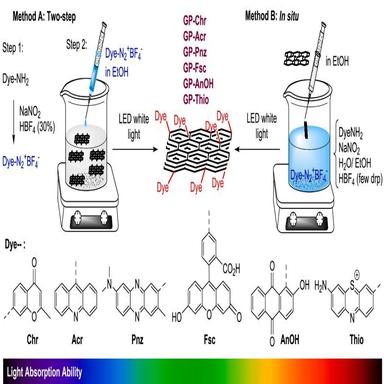
General strategies for fabricating graphene-dye composites: Method A (two-step procedure) and Method B (in situ one-pot).